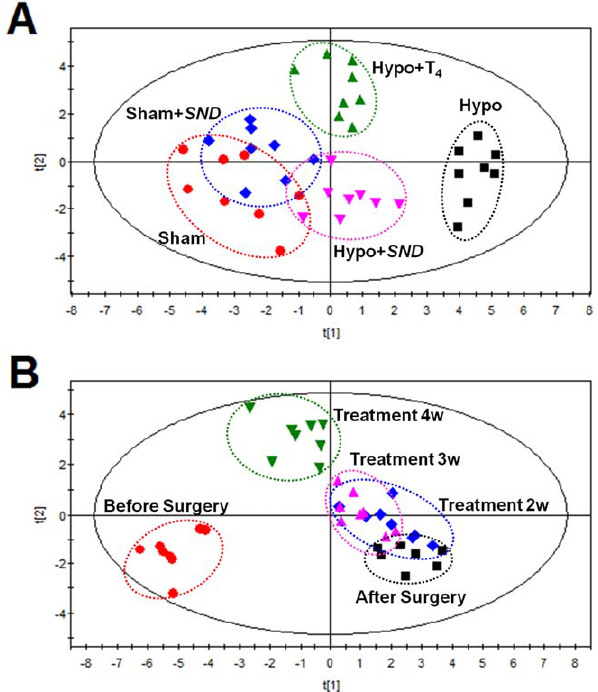
Figure 5. PLS-DA scores plot to evaluate the therapeutical effects of SND. ( A ) PLS-DA scores plot derived from urine levels of 21 potential biomarkers in Sham group (dot), Sham + SND group (diamond), Hypo group (box), Hypo + SND group (inverted triangle) and Hypo + T 4 group (triangle). ( B ) A time-related trajectory of metabolite patterns from PLS-DA model classifying the state of rats at different time points: before surgery (dot), after surgery (box), treatment for two weeks (diamond), treatment for three weeks (triangle); treatment for four weeks (inverted triangle).